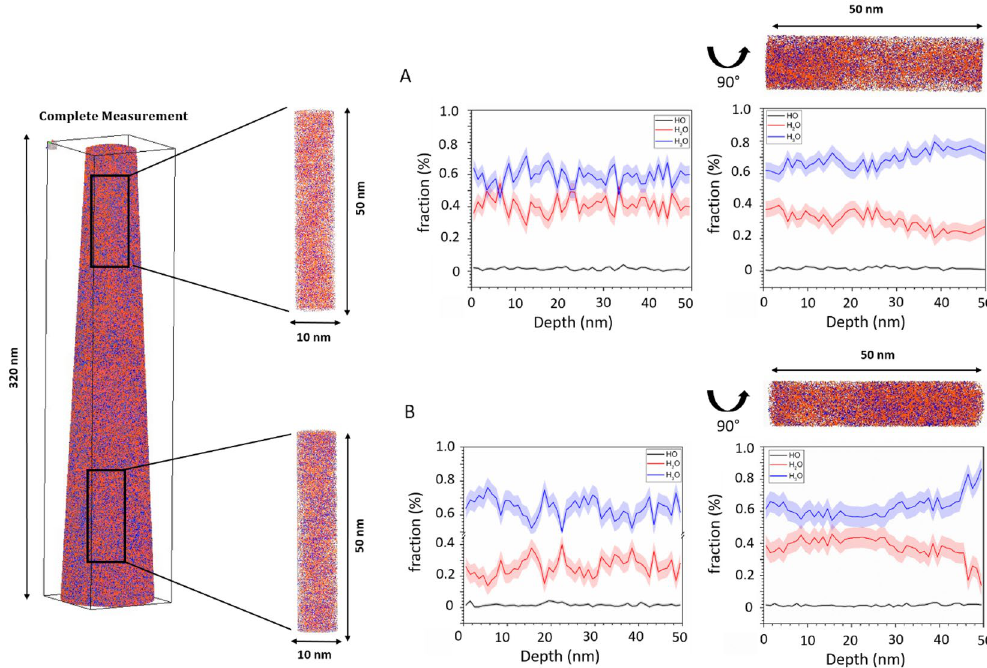
Figure 4. Representative 3D reconstruction of a measured specimen with a total length of 320 nm. A cylinder with a dimension of 10 × 10 × 50 nm was selected vertical and horizontal to the tip from the total volume to analyse the composition profile of the H x O molecules with x =